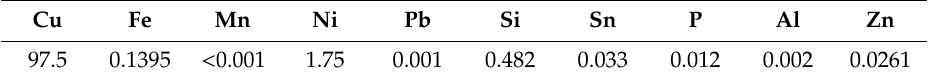
Table 1. Chemical composition of CuNi 2 Si alloy (wt %).